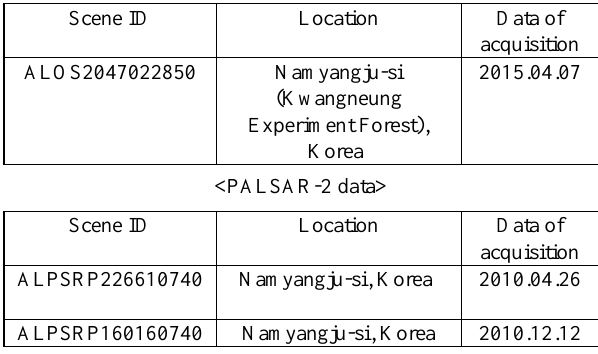
Table 1. Characteristics of the used PALSAR-2 and